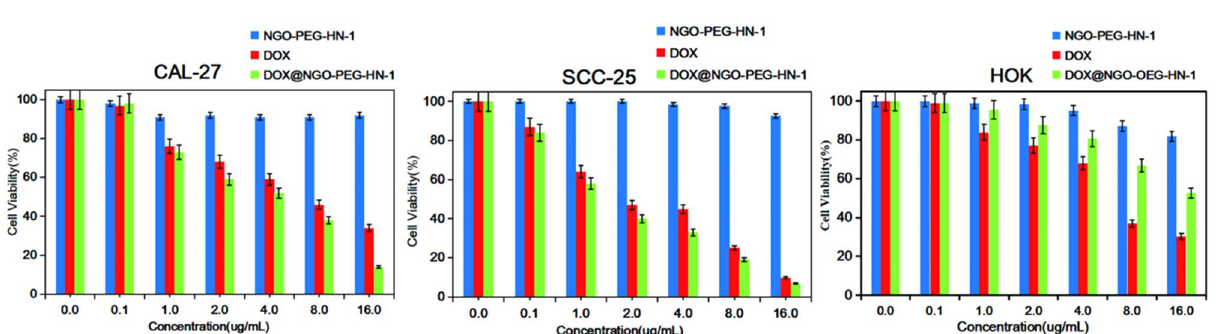
Figure 10. FITC, DAPI, and DOX images of CAL-27 and SCC-25 cells treated with DOX@NGO-PEG-HN-1- FITC.